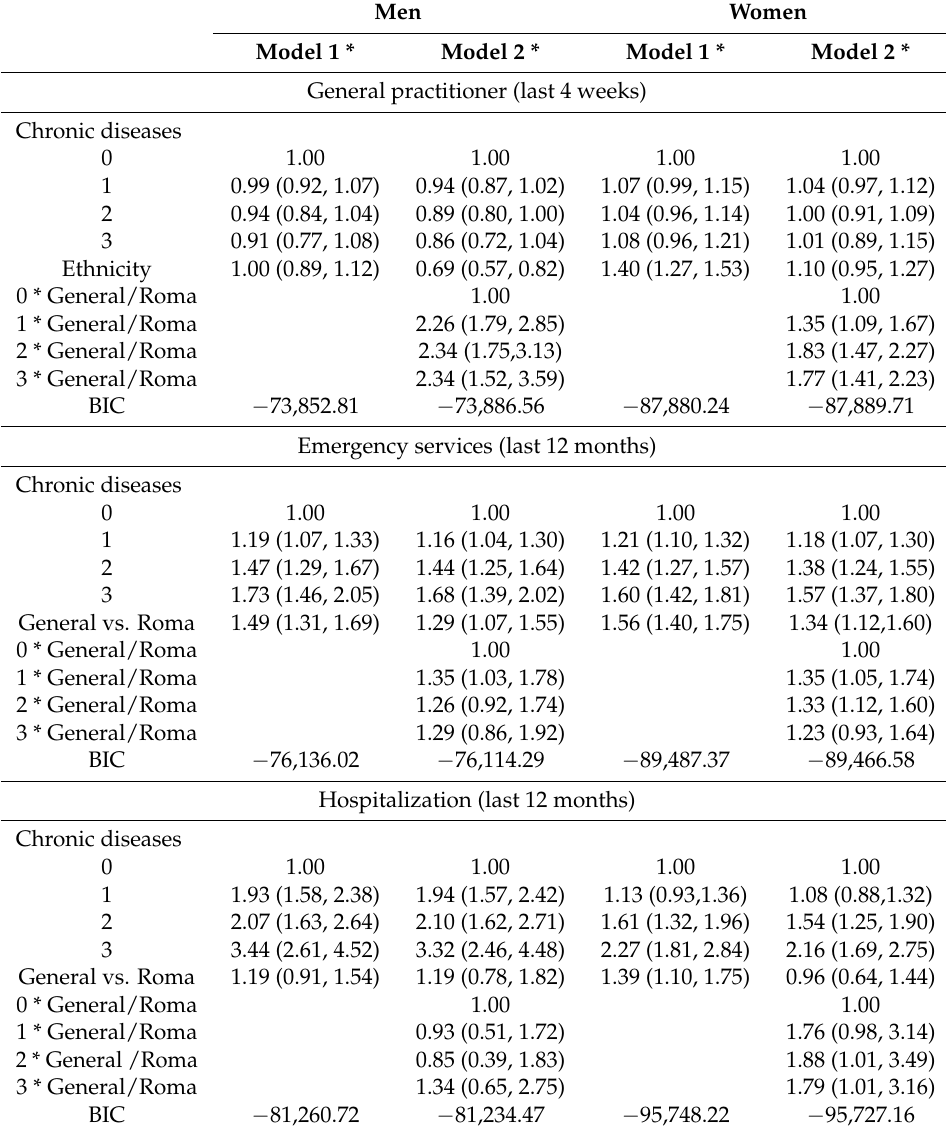
Table 3. Prevalence ratios (with 95% CI) for the use of healthcare services according to health need (comorbidity) by men and